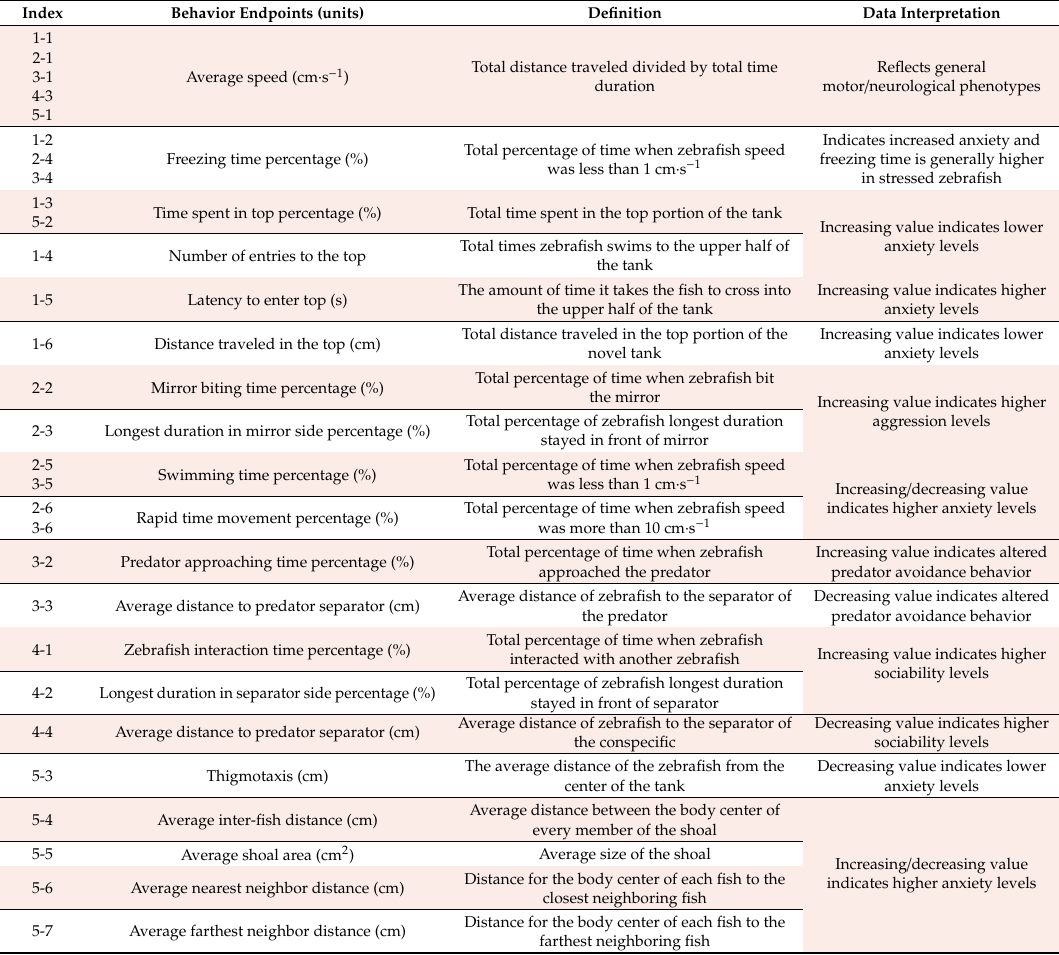
Table A1. Summary of zebrafish behavior endpoints measured from the novel tank, mirror biting, predator avoidance, social interaction, and shoaling